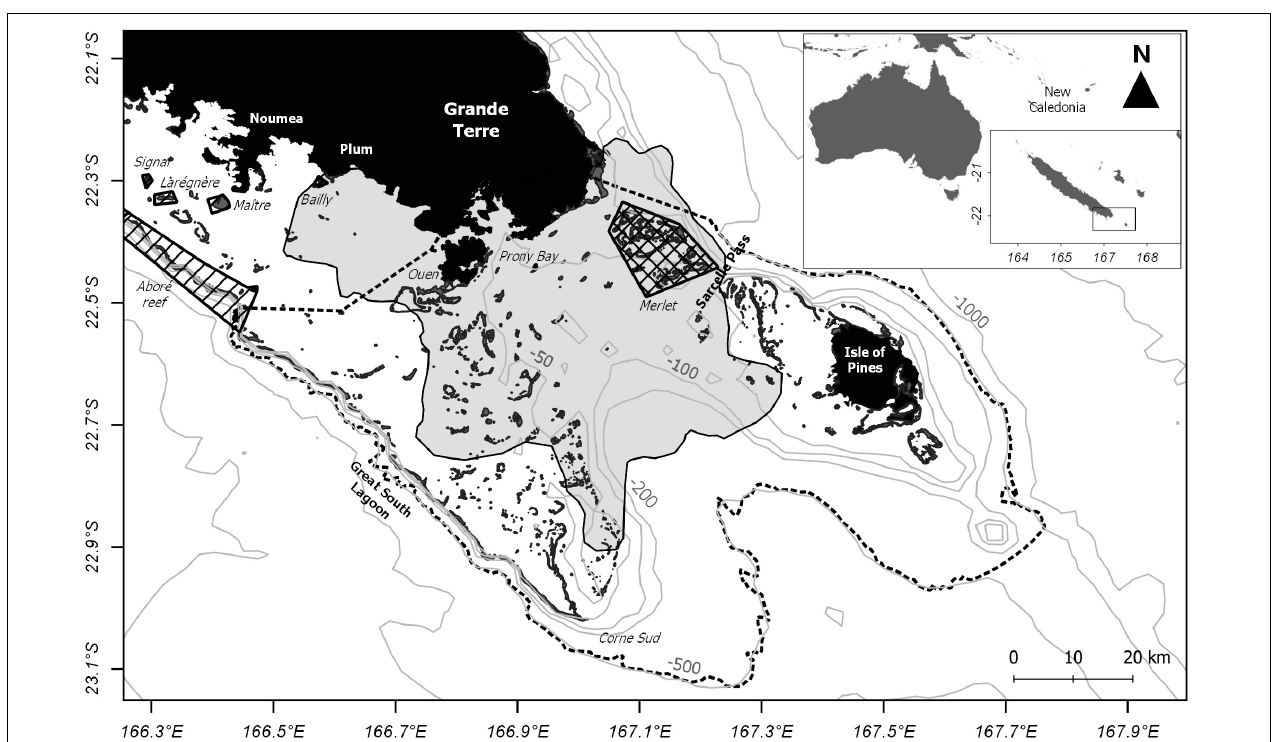
FIGURE 1 | Map of the study area in the southern range of New Caledonia (South Pacific). Land and shallow reefs are shown in black. Winter study area with recorded effort during humpback whale season is shown in light gray. Delimitation of the provincial Park “Great South Lagoon” is shown with a dotted line. Polygons represent Integral Marine Protected Areas (gridded) or natural reserves with restrictions (hashed). Light gray lines represent 50–1000 m